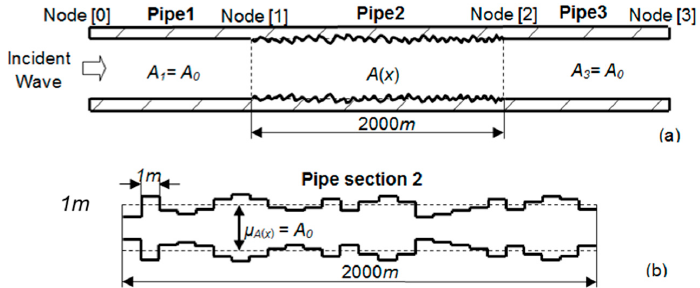
Figure 8. Schematic of numerical pipeline system: ( a ) three-section pipeline; ( b ) middle disorder section for testing.